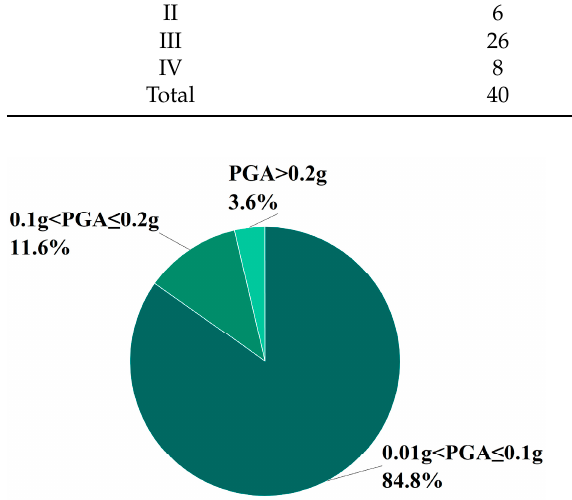
Figure 1. Distribution of PGA.